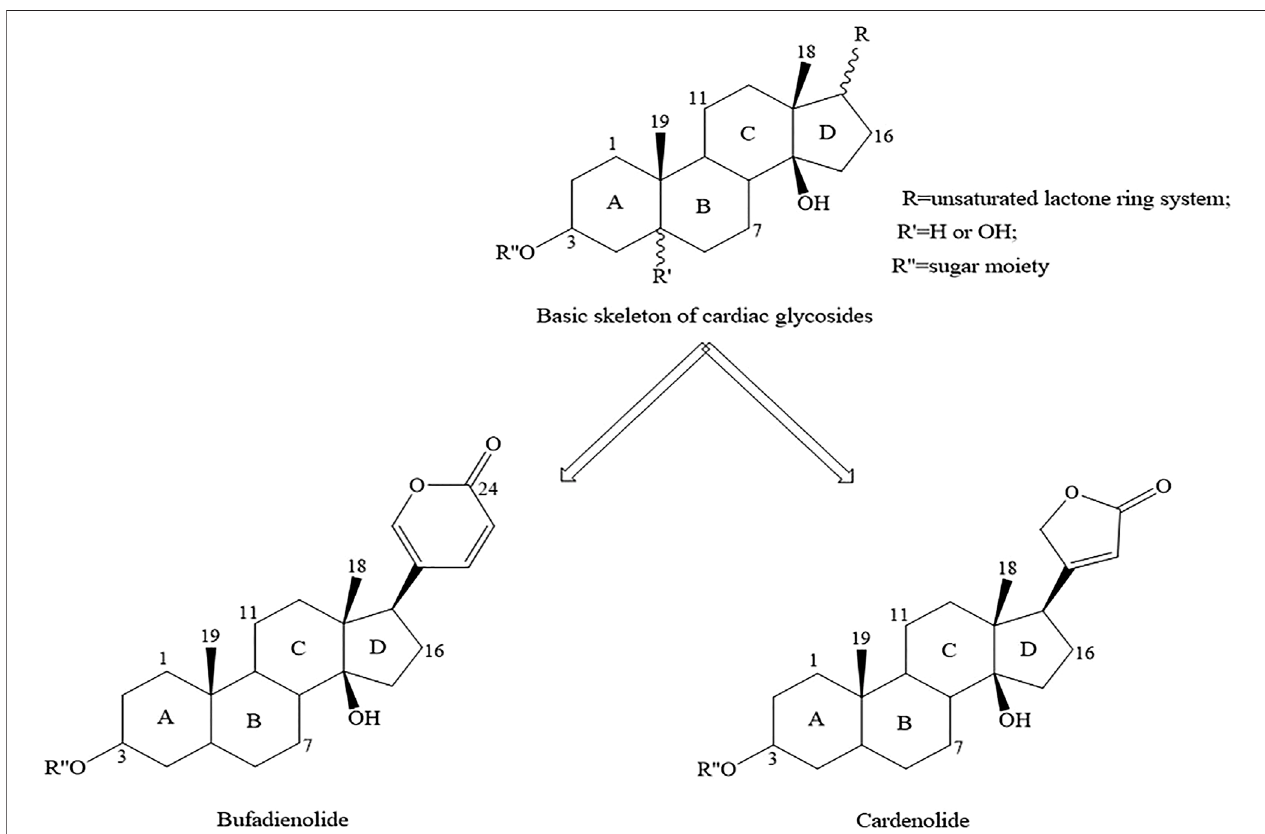
FIGURE1| BasicskeletonofCGs.CGsisthemostcommontypeofCTS.Thelactonemoietyde fi nesthefunctionalclassofeachcompound.Cardenolidescontain a fi ve-membered unsaturated butyrolactone ring, whereas bufadienolides contain a six-membered unsaturated pyrone ring.